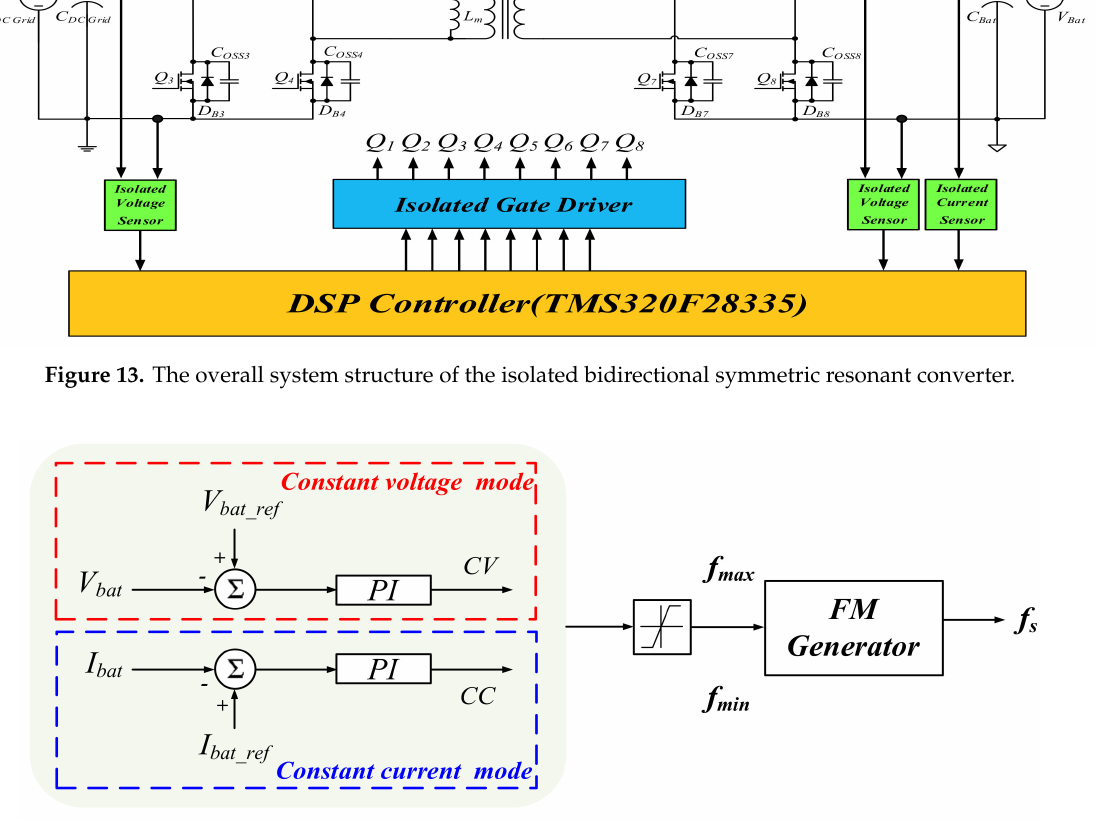
Figure 14. The functional block diagram of the battery